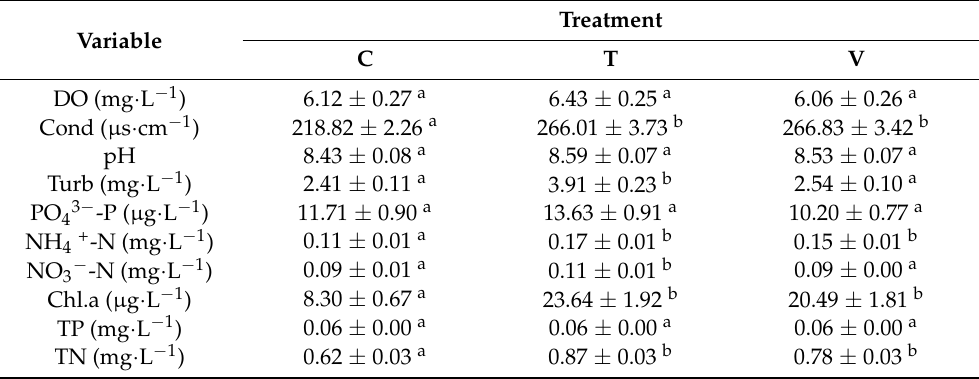
Table 1. Mean water quality for all treatments during the experiment. Values were calculated from bi-weekly measurements of six replicate mesocosms from March 2018 to February 2019. Values are given as means ± SE. C, ambient temperature; T, +4 ◦ C constant warming; V, variable warming. The letters above the data represent significant differences between treatments ( p <